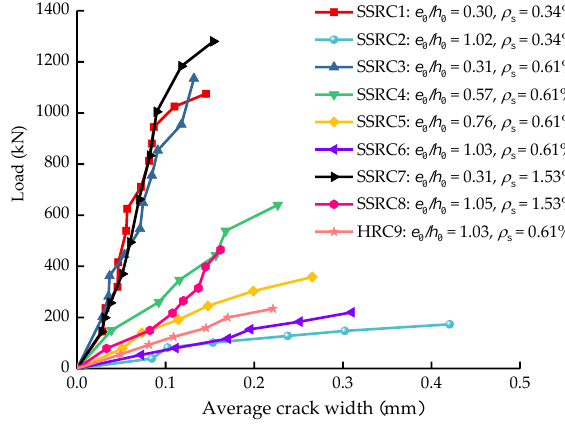
Figure 12. Load – average crack width curves.